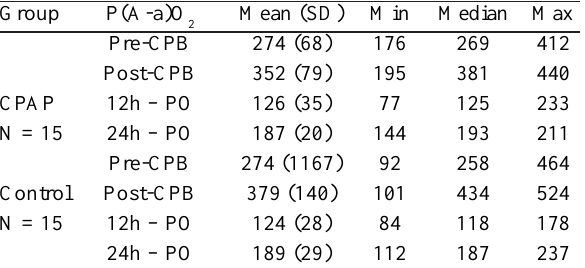
When PaO /FiO were subdivided into three categorical 2 2 values, a greater prevalence of patients with PaO